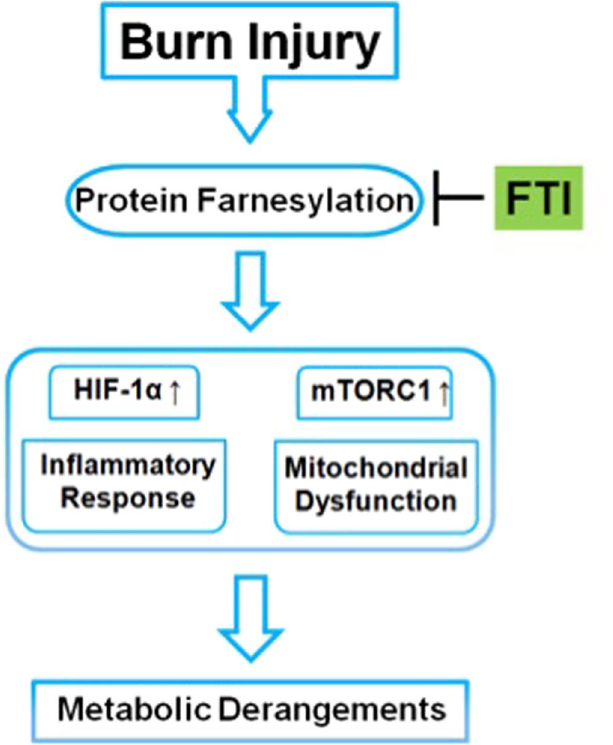
Figure 9. Schematic presentation of the proposed model: Role of protein farnesylation in burn-induced metabolic derangements. Our data indicate that protein farnesylation causes and/or exacerbates activation of the HIF-1 α pathway and mTORC1, mitochondrial dysfunction, and ER stress, all of which contribute in concert to burn-induced muscle metabolic derangements, including insulin resistance and increases in lactate production and protein breakdown. Farnesyltransferase (FTase) inhibitor (FTI) prevents burn- induced metabolic derangements by inhibiting or mitigating the impact of burn injury on HIF-1 α , mTORC1, mitochondria, and ER stress in mouse skeletal